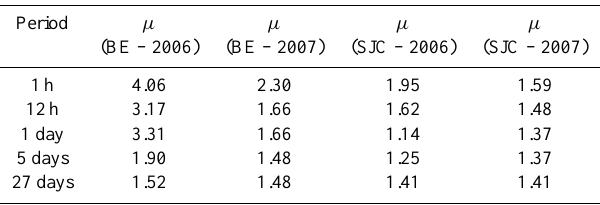
Table 2. The α parameter for each characteristic scale for both sites and